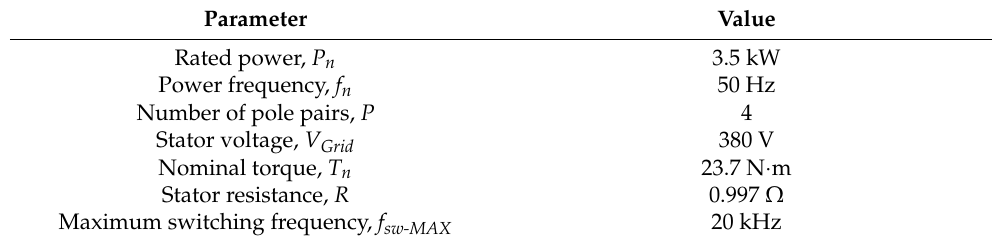
Table 3. 3.5 kW PMSG parameters.